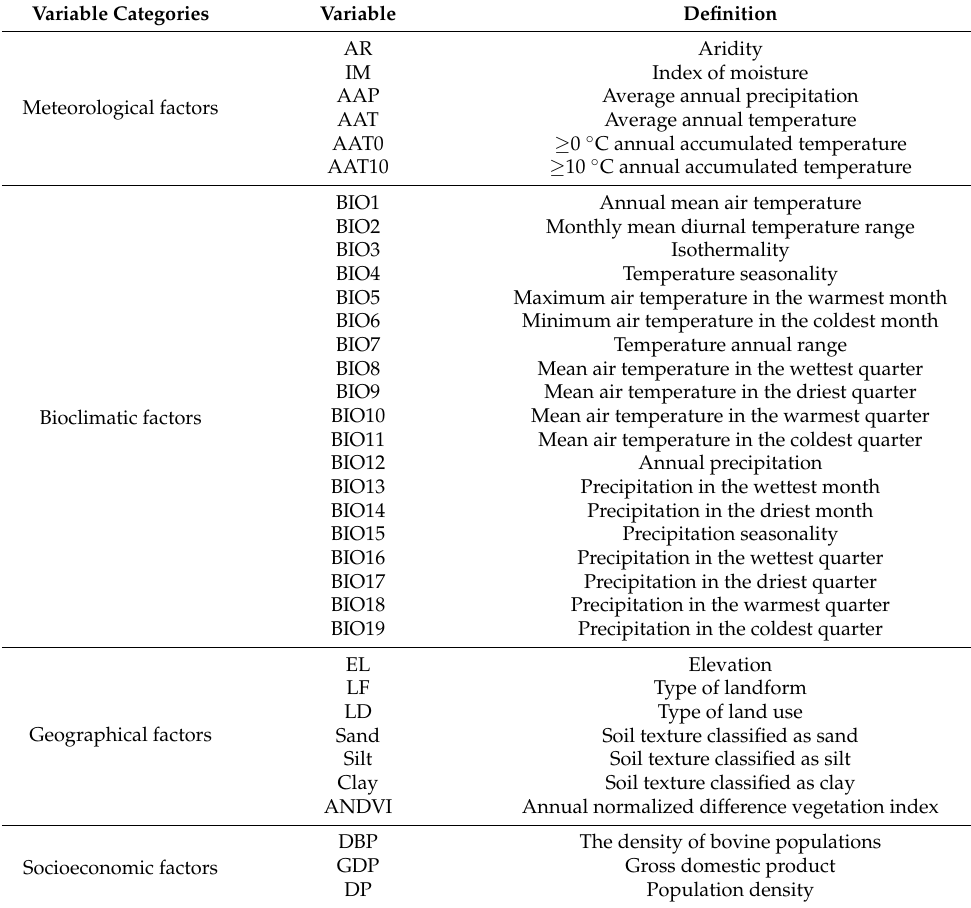
Table 1. Environmental factors affecting the distribution of